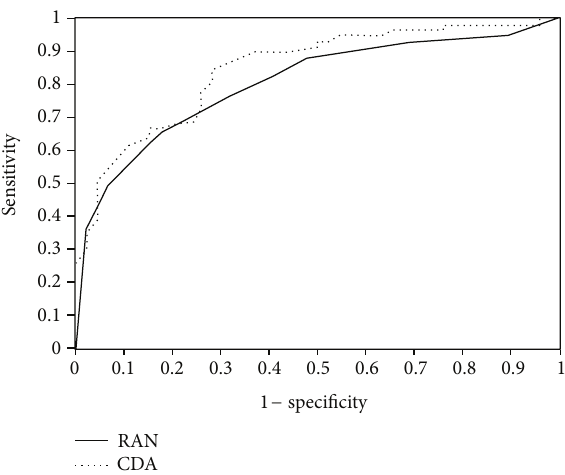
Figure 1: Areas under the receiver operating characteristic curve (aROCs) of the best classifier trained with the number of spec- tral domain optical coherence tomography (SD-OCT) parameters which allowed the best performance (RAN: random forest = 0.877) and aROC of the best SD-OCT parameter (CDA: cup/disc area = 0.846) ( 𝑃 = 0.542